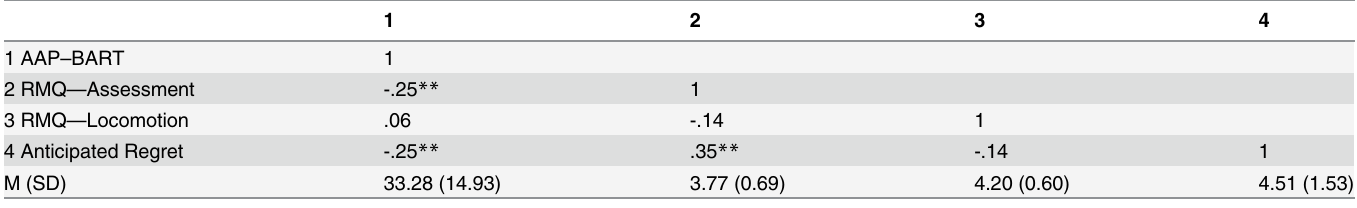
Table 1. Means, Standard Deviations and Intercorrelations between Independent Variables, Mediator and